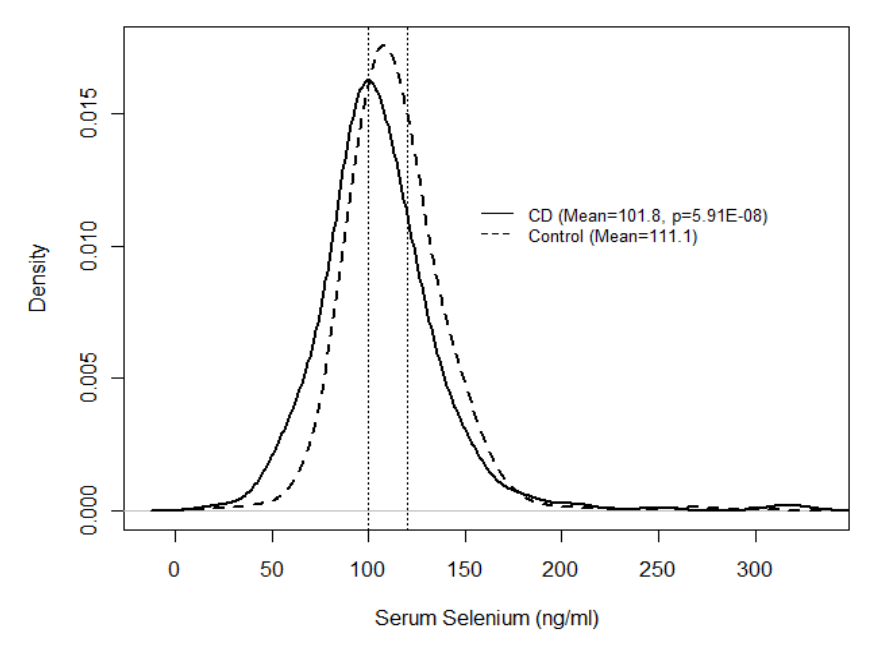
Figure 1. Distribution of serum selenium measures by CD and control group.